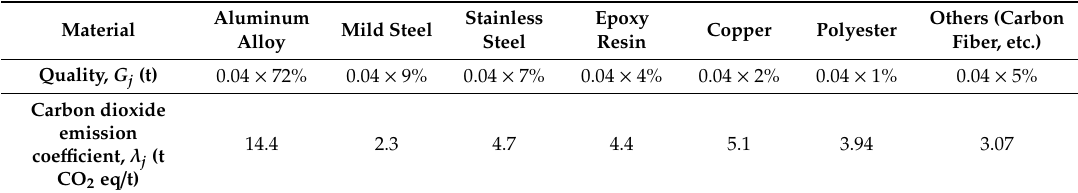
Table 8. Quality of the key materials required for a wind turbine fabrication and the corresponding carbon dioxide emission coe ffi